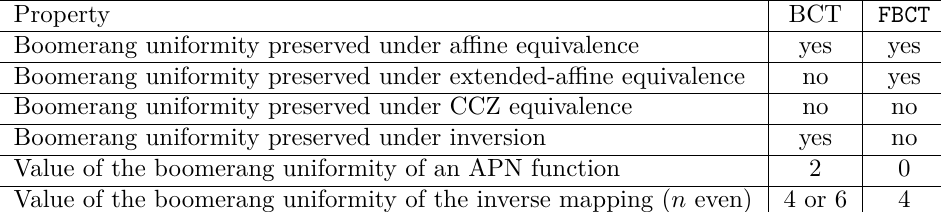
Table 2: Comparison of the properties of the BCT and of the FBCT of n -bit functions. Property BCT